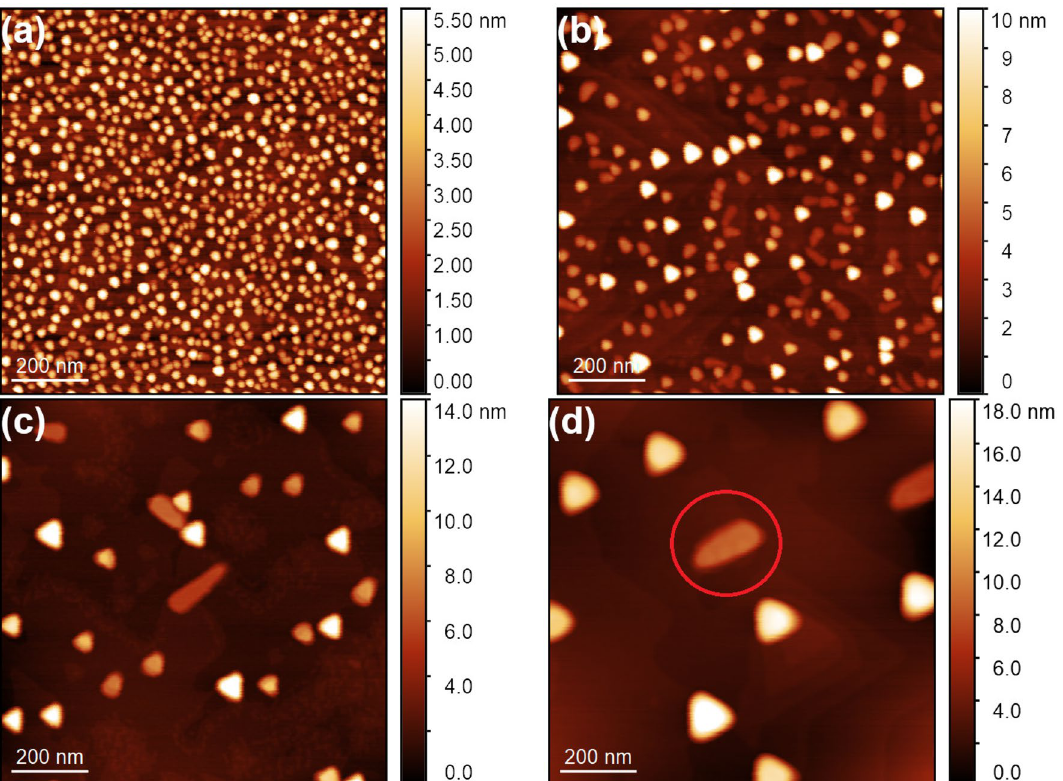
( 1 × 1 µ m 2 , sample T1); (b) 350 ◦ C ( 1 × 1 µ m 2 , sample T2); (c) 400 ◦ C ( 1 × 1 µ m 2 , sample T3); (d) 450 ◦ C ( 1 × 1 µ m 2 , sample T4). The red circle highlights a kinked